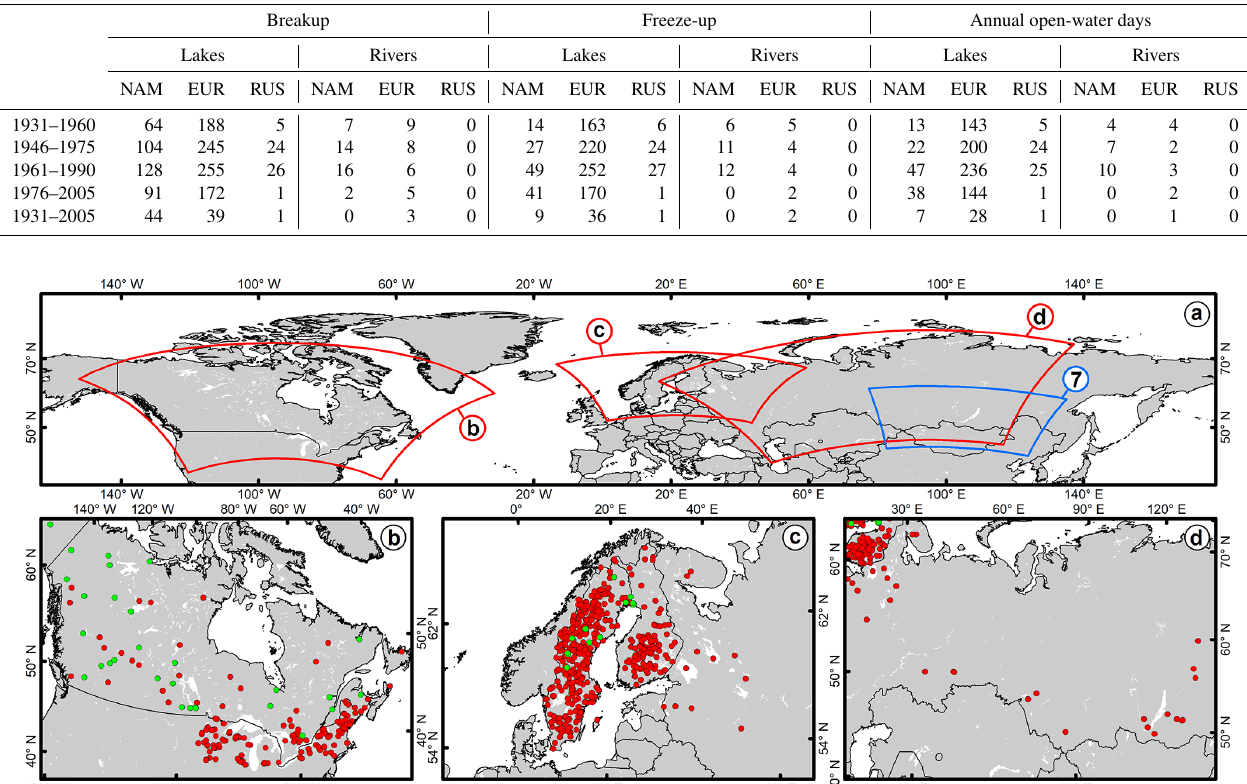
Figure 1. (a) Map showing the three main study areas. The red and green circles in panels (b) – (d) are lake and river sites, respectively, that have time series containing at least 90% coverage for breakup and/or freeze-up during at least one time period. The majority of river sites are located in Canada, with Russia only having data available for lakes. The geographical extent used in panels (b) – (d) for each region of interest is the same in subsequent figures. The zoomed-in extent of the Russian study area in Fig. 7 is shown by the blue outline on (a) .